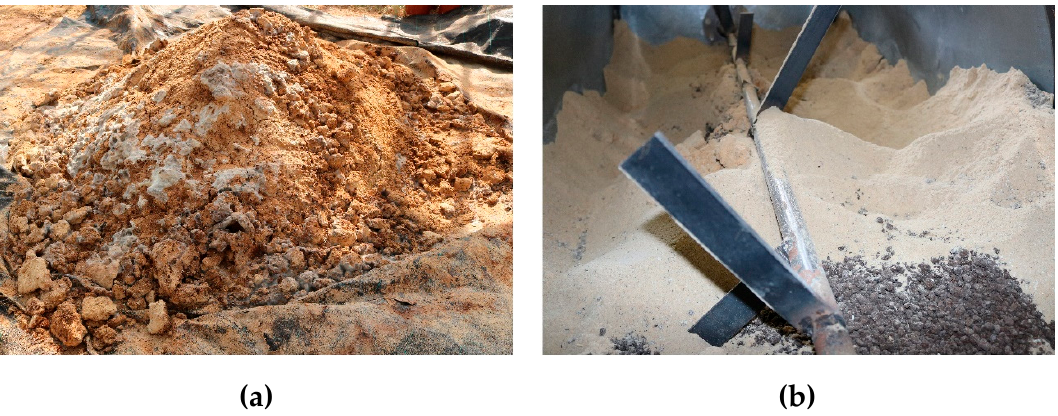
Figure 1. The materials during composting process (a) and the compost bin (b) .